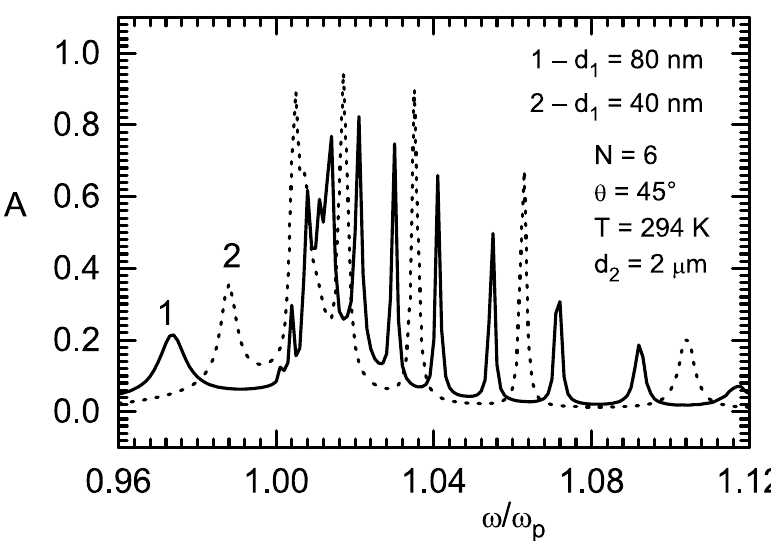
Figure 4. Absorptance A as a function of the relative frequency ω / ω p for the quantum electron plasma at the graphite layer number N = 6, incidence angle θ = 45 ◦ , temperature T = 294 K, and quartz layer thickness d 2 = 2 µ m, for various graphite layer thicknesses: 1 − d 1 = 80 nm (solid line); 2 − d 1 = 40 nm (dotted